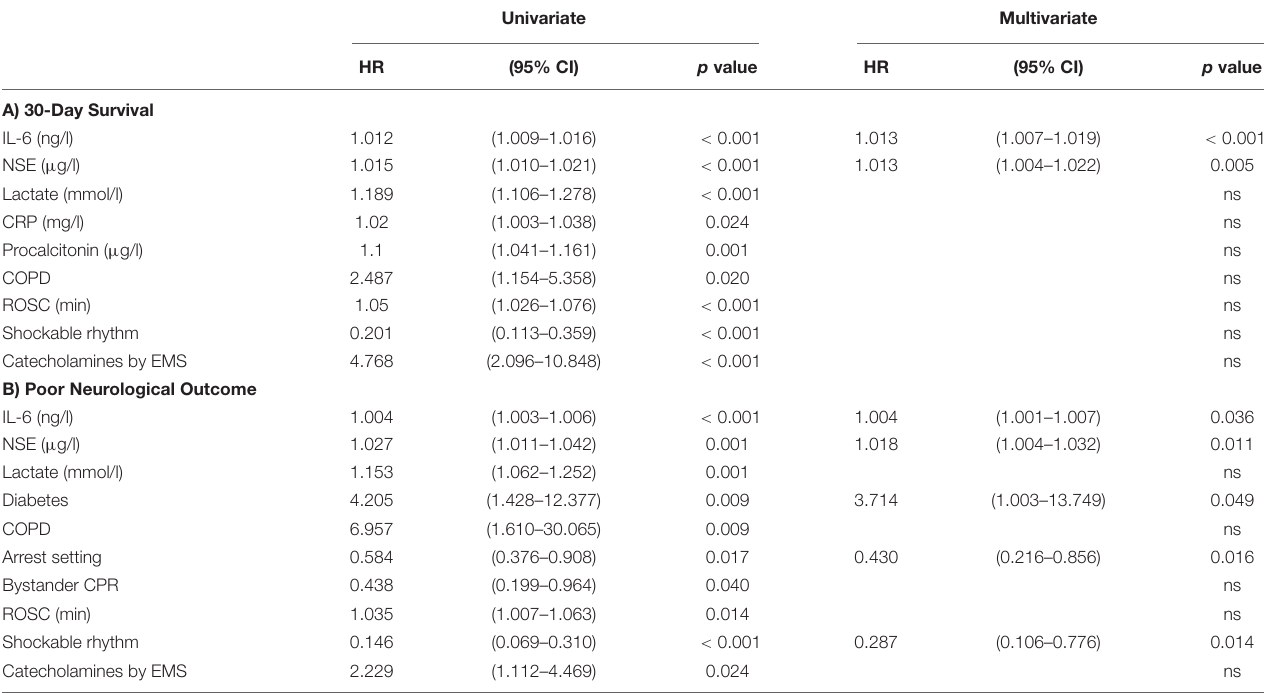
TABLE 2 | Univariate and Multivariate Cox regression Analysis for (a) 30-day survival and (b) poor neurological outcome. Univariate Multivariate